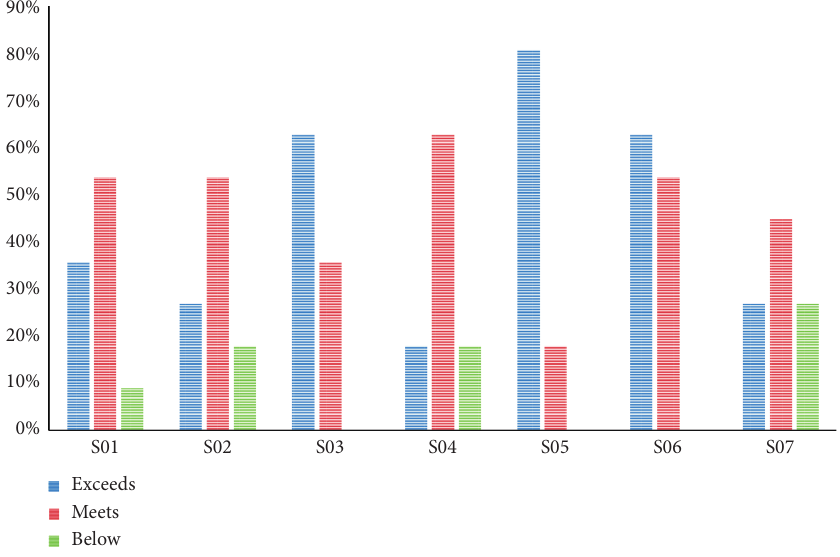
Figure 13: Student outcome assessment results ( n � 11).